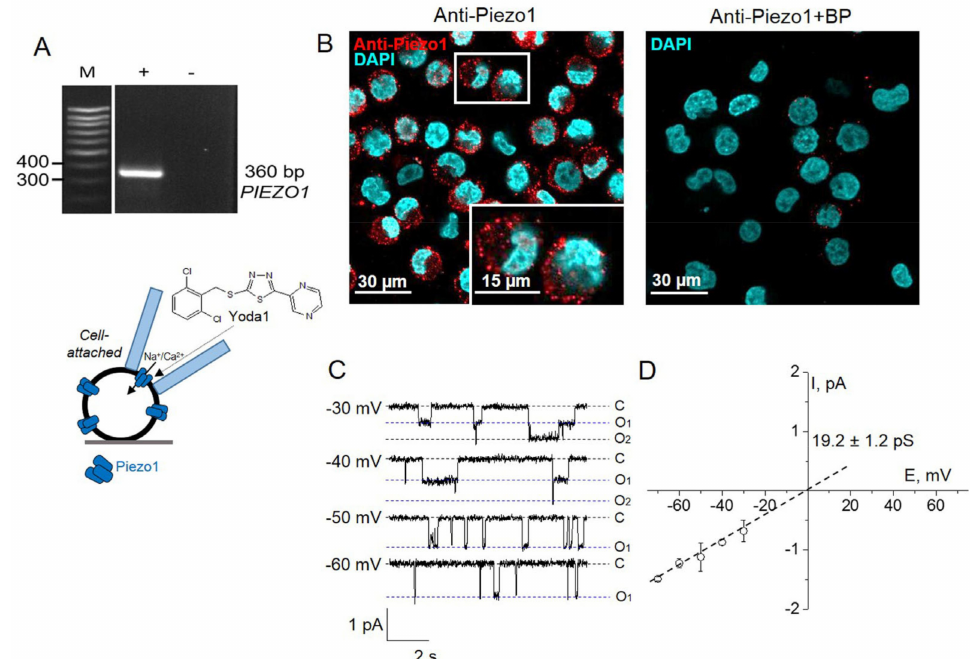
Figure 1. Piezo1 is expressed in human leukemia K562 cells. ( A ) RT-PCR analysis revealed the presence of hPIEZO1 mRNA. Cropped gel with enhanced contrast is shown. ( B ) Immunofluorescent staining with specific antibodies detected Piezo1 proteins (Anti-Piezo1, red channel) in the cells. Cell nuclei were counterstained with DAPI (blue channel). Cells in white frame are shown in 2 × zoom. No staining of the cells was observed after pre-incubation of the anti-Piezo antibody with the specific corresponding blocking peptide (Anti-Piezo+BP). ( C ) The single-channel activity of Piezo1 induced by Yoda1 (10 µ M in the pipette solution) recorded in the representative cell-attached experiment at different membrane potentials. Here and elsewhere, the index shows a number of active channels (C—closed state (zero current), O—channel openings). Holding membrane potential is indicated near current traces. ( D ) The mean I-V relationship corresponds to a single-channel conductance of 19.2 ± 1.2 pS ( n =